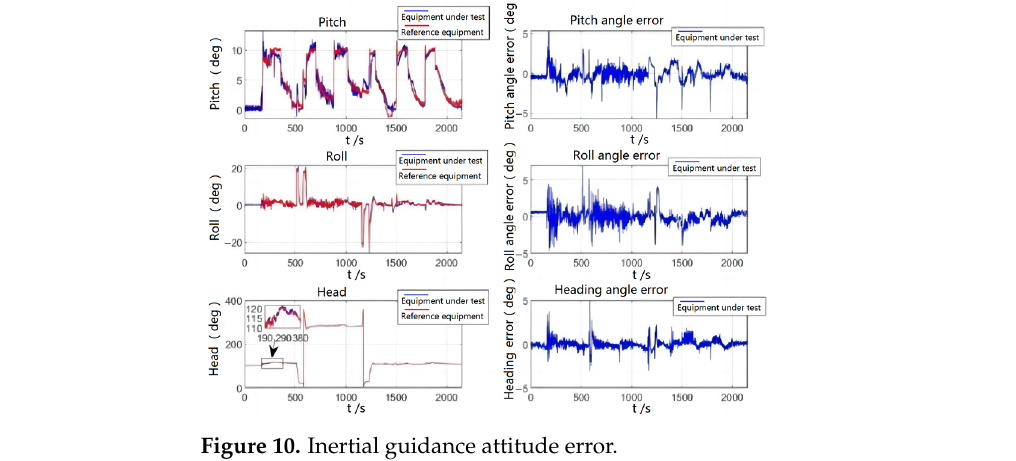
Figure 10. Inertial guidance attitude error. Table 5. Inertial guidance attitude